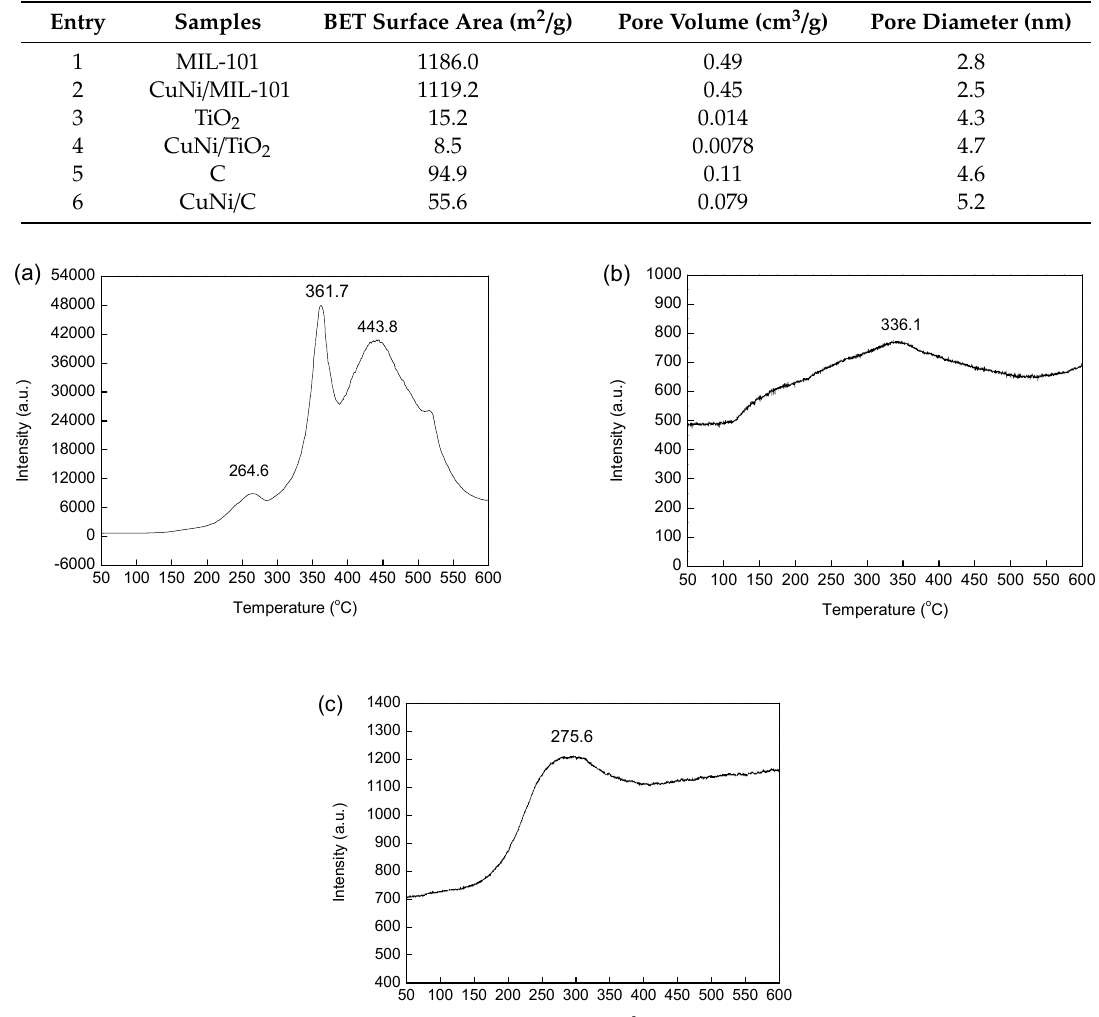
Table 1. The physicochemical properties of supports and the as-prepared Cu-Ni-supported catalysts.